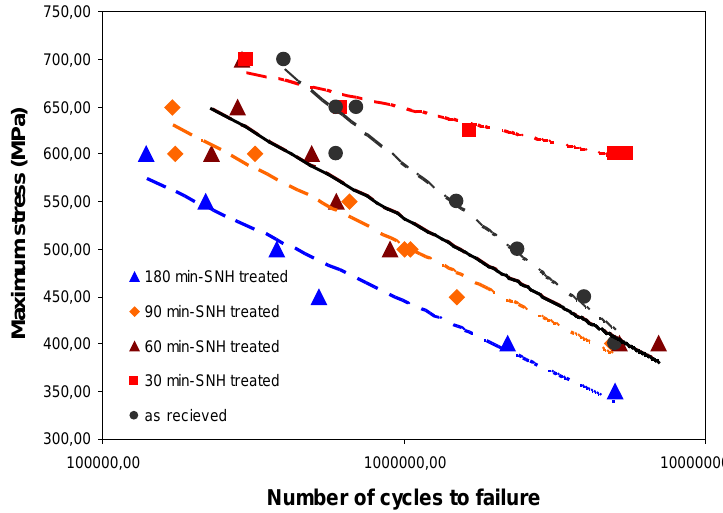
Figure 5: Fatigue behavior of SNH treated Ni-based C-2000 super alloy samples